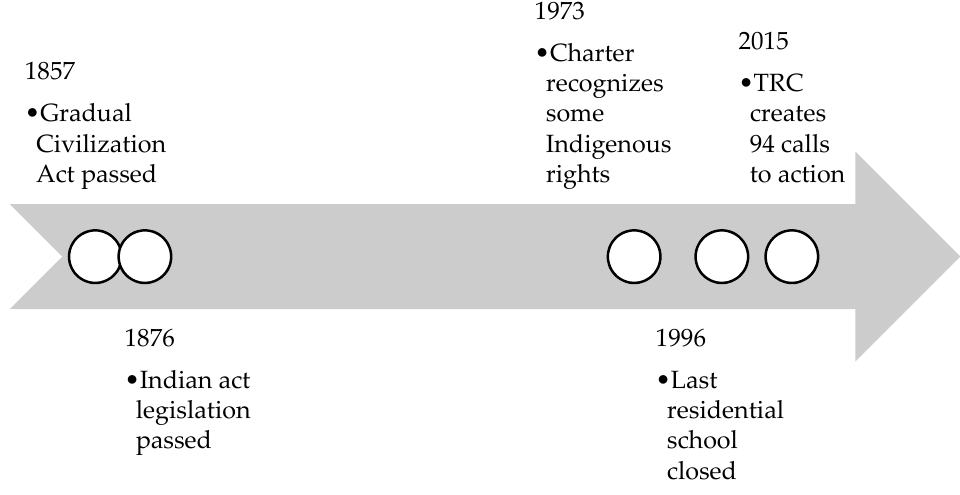
Figure 2. Key events in Canada’s Indigenous language history.